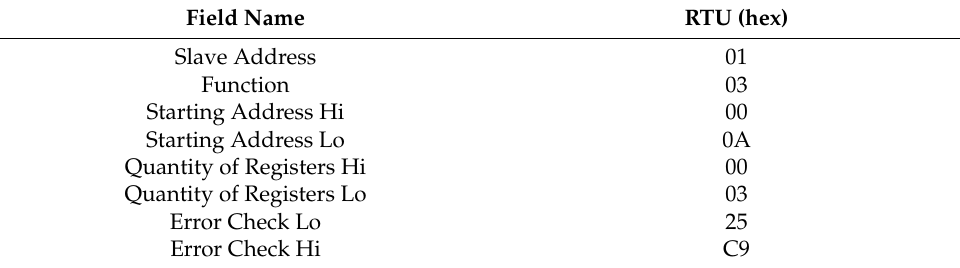
Table A4. Read values from charger.